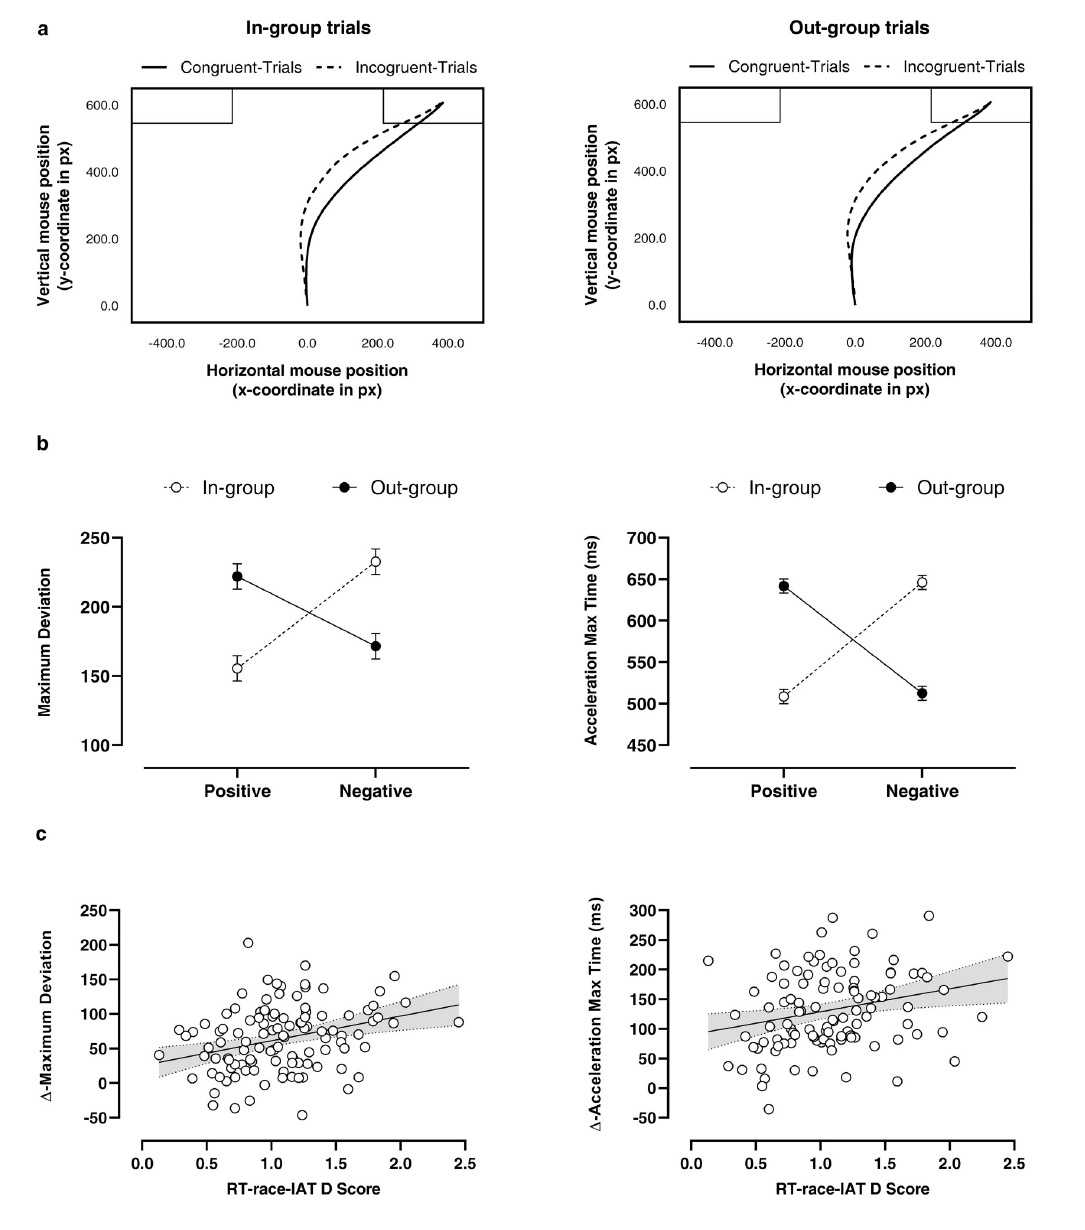
Fig 3. Panel ( a ), average real-time mouse trajectories for congruent and incongruent in-group trials (left panel) and congruent and incongruent out-group trials (right panel) in the MT-race-IAT task. Panel ( b ), MT-metrics differences collected during the experimental task. The line-plot graphs represent the Maximum Deviation (left panel) and Acceleration-Max-Time (right panel) data as a function of attribute type and actor’s race. Values are expressed as mean ± SEM. Panel ( c ), linear regressions between RT-race-IAT D Score vs Δ - Maximum Deviation (left panel) and Δ -Acceleration-Max-Time (right panel); the solid line indicates the best linear model, and the dashed lines indicate the 95% confidence